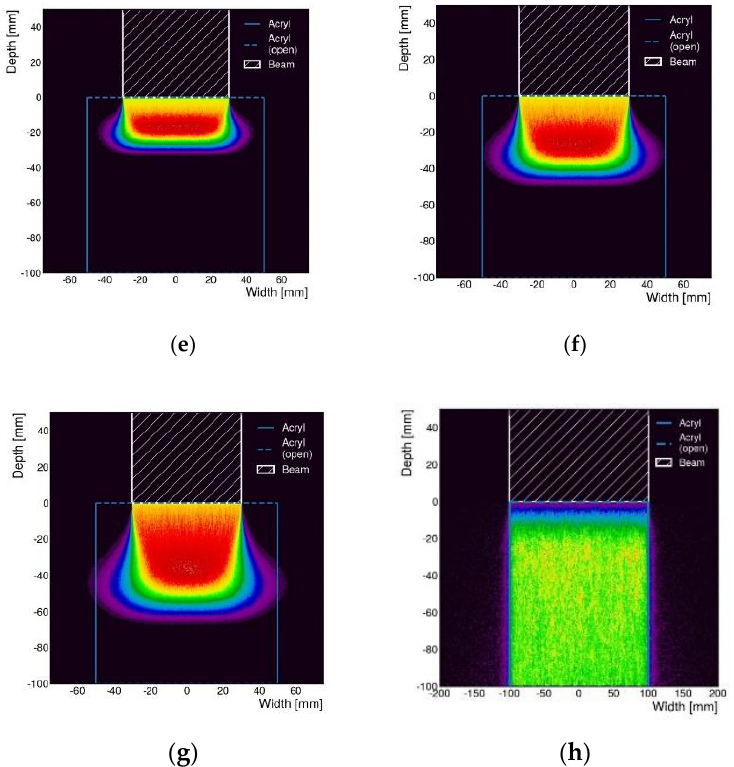
Figure 5. ( a – c ) Only pixels with a V value of 30% or more were selected among the 6, 9, and 12 MeV electron beam fluorescence images to reconstruct the photo image. The contour color indicates the amount of energy absorbed by AbLS. Red color means more energy absorption. ( d ) Only pixels with a V value of over 60% were selected in the gamma ray image. The 2D PDD MC simulation results with AbLS for 6, 9, 12 MeV electron beams and gamma ray are shown in ( e – h ), respectively. The solid blue line indicates the boundary of the container, the dashed blue line indicates the open top side of the container, and the white hatched area represents the area of the incident particle beam. More cyan, blue, and violet colors exist in the MC dose distribution. The dose in the MC and pixel image increases from blue to magenta.